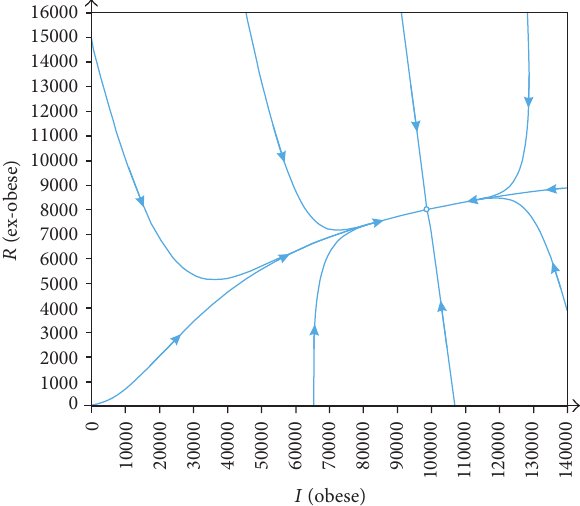
Figure 15: Phase portrait for system (4) for the case 𝜖 = 0.012 > 0 (considering 𝛽 = 2.96 × 10 −7 ).